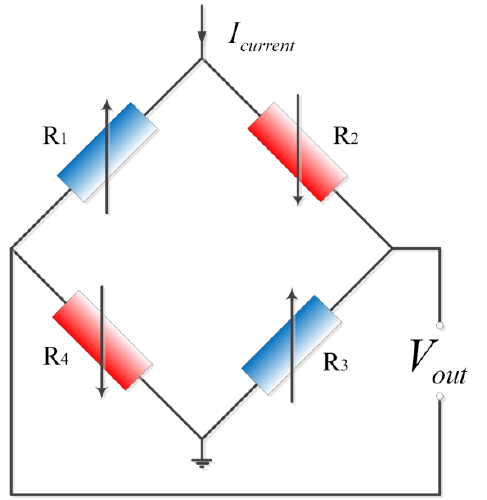
Figure 1. Schematic of the piezoresistive pressure